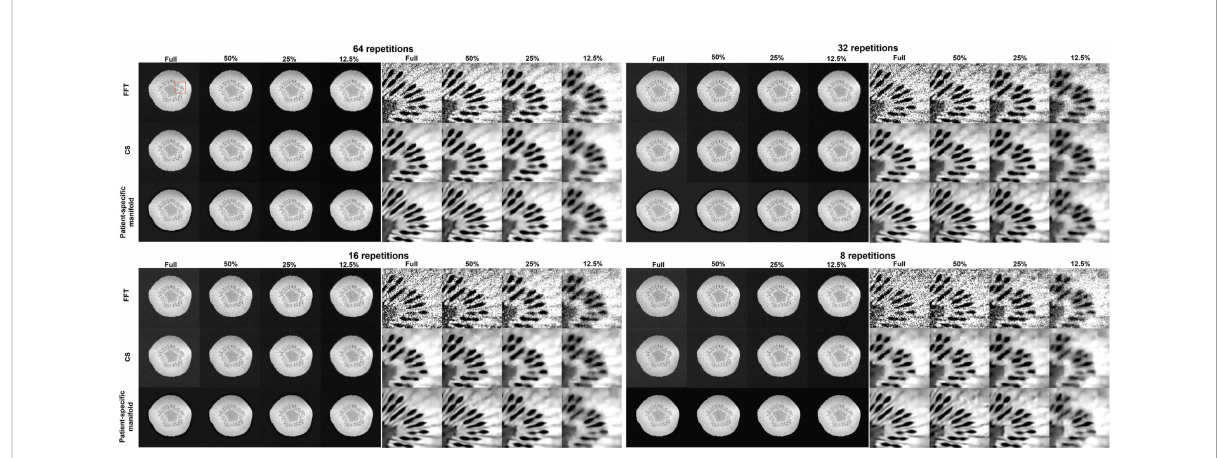
FIGURE 11 Reconstruction results of the kiwi using data with different undersampling ratios and with varying noise levels by adjusting the number of scan repetitions. These are reconstructed using a Fast Fourier Transfer (FFT), a tight-frame compressed sensing method (CS), and the proposed patient-speci fi c manifold. The complete images are displayed in a window of [0, 1] and the zoomed-in patches are displayed in a narrower window of [0.65, 0.95].